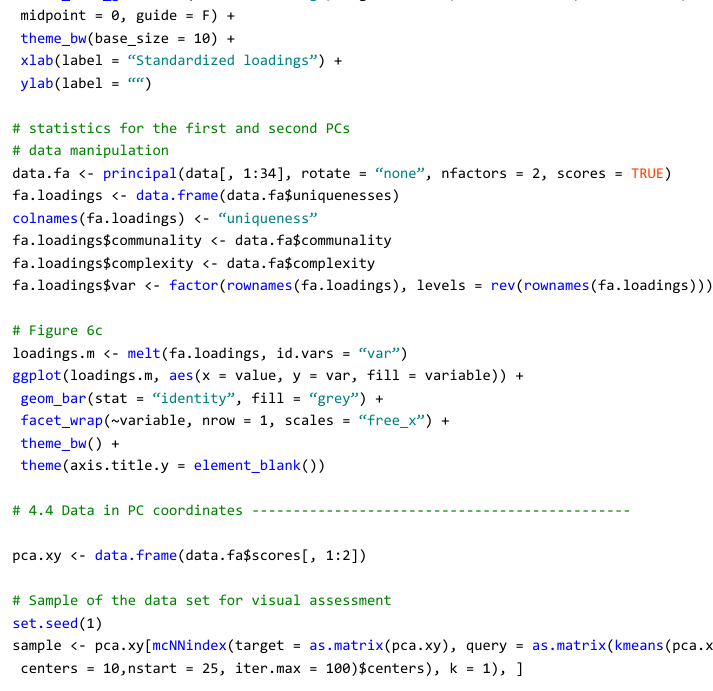
# Figure 7a ggplot(pca.xy, aes(x = PC1, y = PC2)) + geom_bin2d(bins = 200) + scale_fill_continuous(type = “viridis”) + geom_point(sample, mapping = aes(x = PC1, y = PC2), size = 1, color = “red”) + geom_label_repel(sample[order(sample[, 1]), 1:2], mapping = aes(x = PC1, y = PC2,